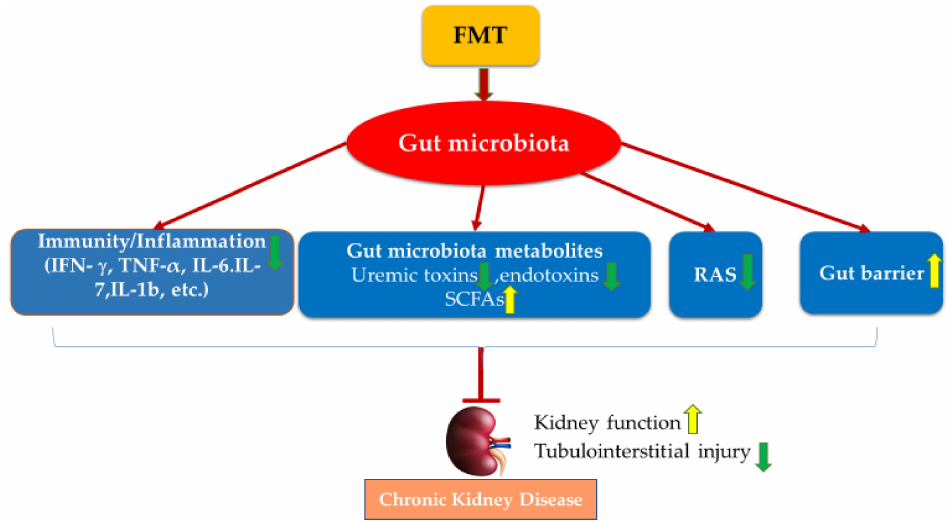
Figure 1. Potential mechanisms of FMT on managing CKD. FMT improves kidney function and protects against kidney injury via the modulation of gut microbiota dysbiosis, mediated by restor- ing hosts’ immunity, regulating gut microbiota metabolites, inactivating RAS, and improving gut epithelial barrier